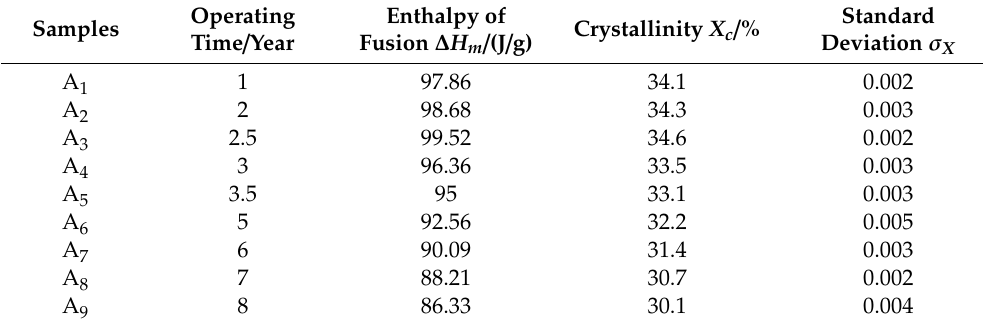
Table 1. The crystallinity of cross-linked polyethylene (XLPE) for each cable sample.